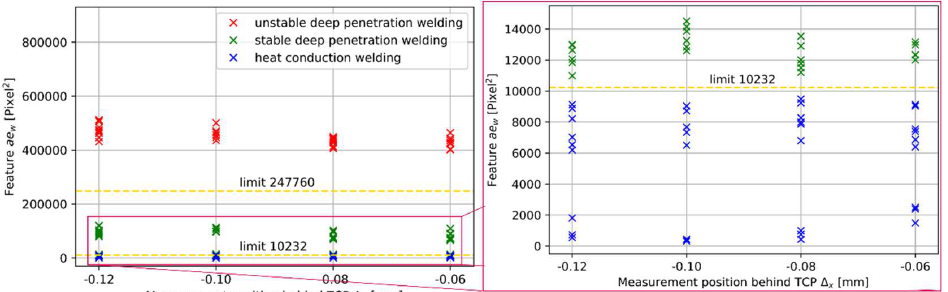
Figure 6. Feature values depending on relative OCT position behind TCP for different process regimes.